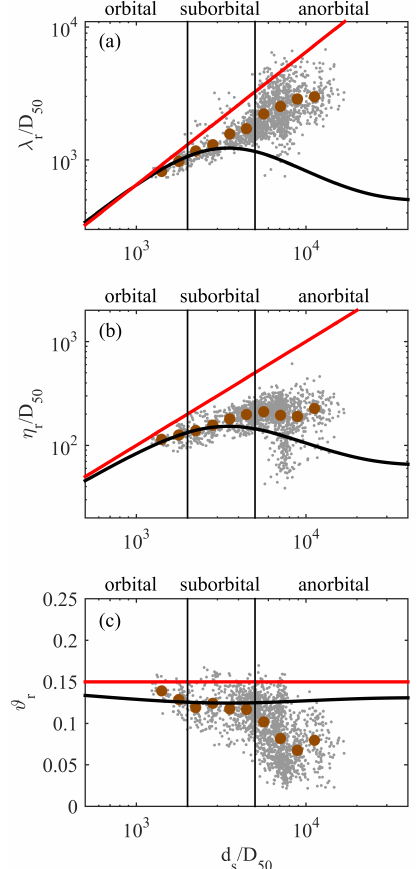
Figure 7. Measured ( a ) ripple length λ and ( b ) ripple height η , normalized by the median r r /D grain size D , and ( c ) ripple steepness ϑ versus normalized orbital diameter d , 50 r s 50 based on all observations at the 16 instrumented locations (1687 observations in total). /D = 2000 and The two vertical lines in all three panels are previously defined values ( d s 50 5000 ; [11,13]) to delineate the orbital, suborbital and anorbital ripple regimes. The curved black line in each plot represents the empirical predictor of Nelson et al. [4] to illustrate /D /D expected orbital-suborbital-anorbital trends in λ , η and ϑ , respectively. The red r 50 r 50 r /D = 0 . 65 , η /D = 0 . 10 and ϑ = 0 . 15 , values often sloping lines in ( a )–( c ) are λ r 50 r 50 r quoted for orbital vortex ripples. The brown dots in each panel are average values computed ( d /D ) from the measurements for 0.1-wide log s 50 10